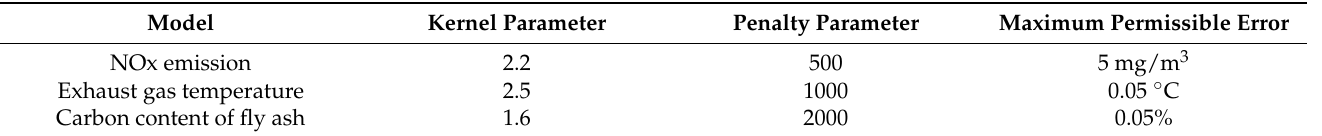
Table 3. Hyper-parameters of the LSSVM models.